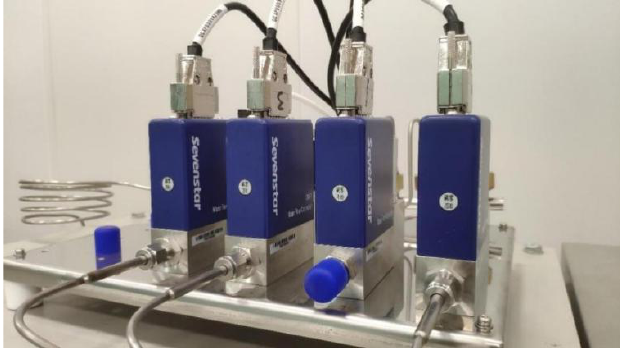
Figure 5. The mass flowmeter for the manipulation of the injection rate of each kind of gas.